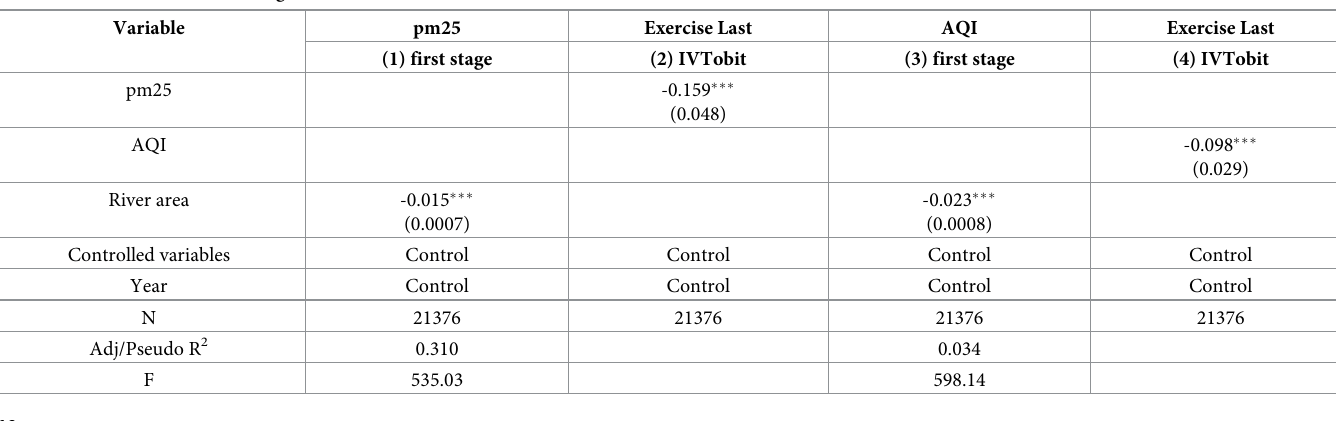
Table 6. Instrumental variable regression results.